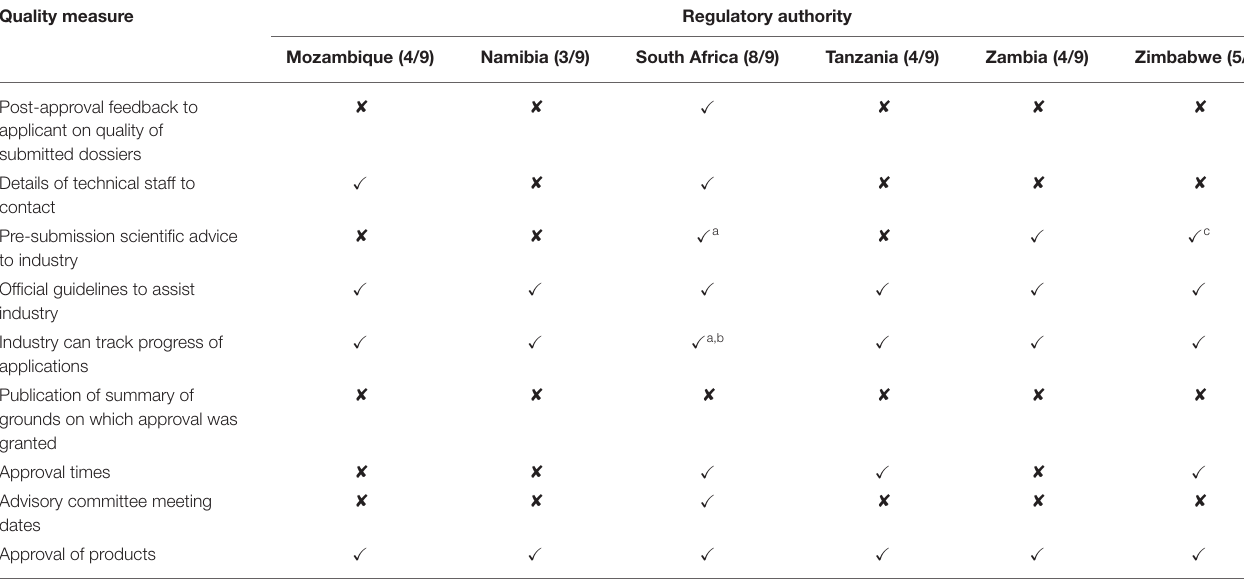
TABLE 4 | Comparison of the transparency and communication parameters in the six